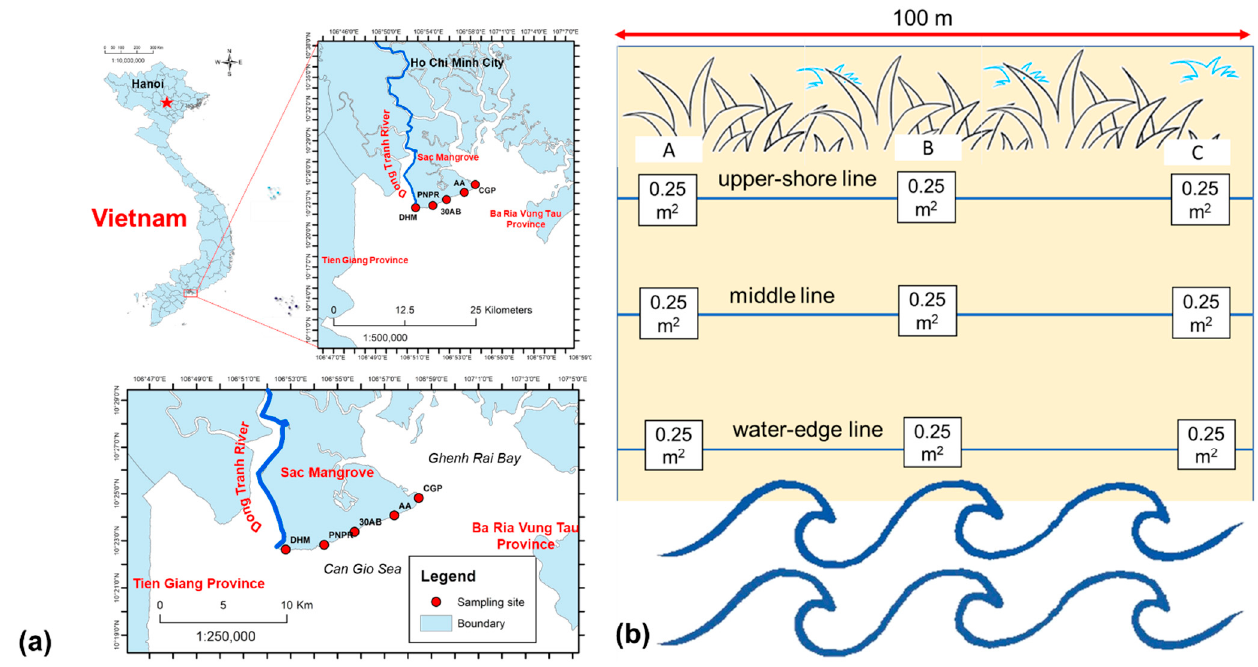
Figure 1. Sampling areas. ( a ) Five sampling areas of beach sand on Can Gio Coast, Ho Chi Minh City, Vietnam in November 2019 (DHM: Dong Hoa Market, PNPR: Phuong Nam Pearl Resort, 30AB: 30 April Beach, AA: Aquaculture Area, CGP: Can Gio Park); ( b ) the sampling area at each beach.